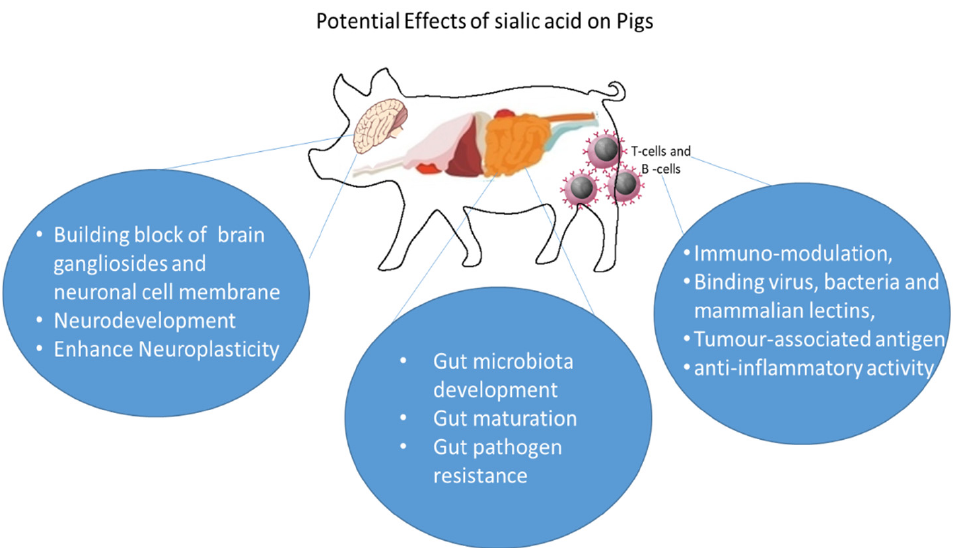
Figure 2. Potential effects of sialic acid on Pigs.